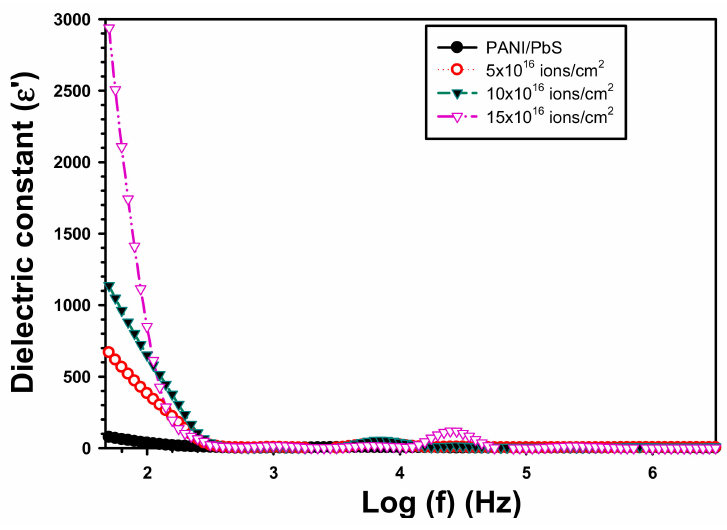
Figure 6. Dielectric constant ε (cid:48) , with frequency for pristine and treated PANI/PbS